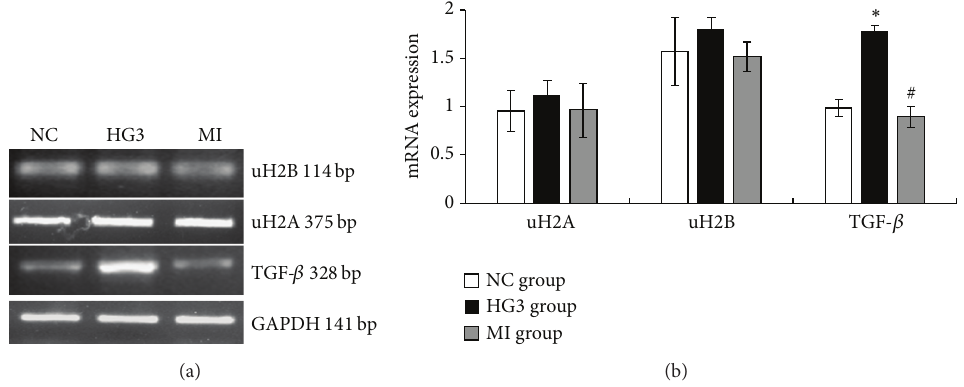
Figure 8: The mRNA levels of uH2A, uH2B, and TGF- 𝛽 in GMCs induced by high glucose and inhibited by MG132. (a) RT-PCR strip chart. (b) The relative gray value statistics graph of the mRNA level. Compared with the NC group, the mRNA levels of uH2A and uH2B were not different between the groups. The expression of TGF- 𝛽 mRNA was greatly increased in the HG3 group and decreased in the MI group compared to the HG3 group. ∗ 𝑃 < 0.01 versus NC group and # 𝑃 < 0.01 versus 1 HG3